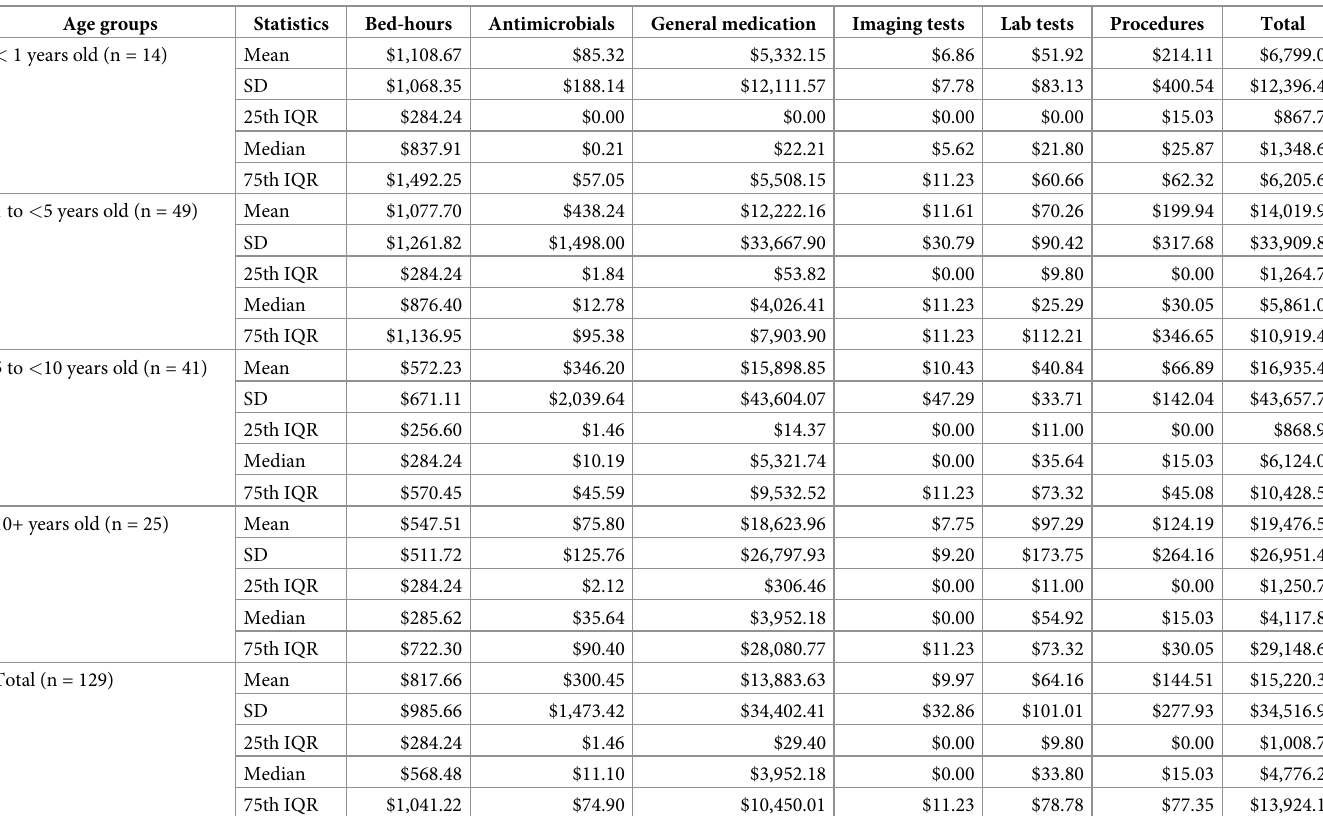
Table 2. Direct costs for patients treated for in the emergency room